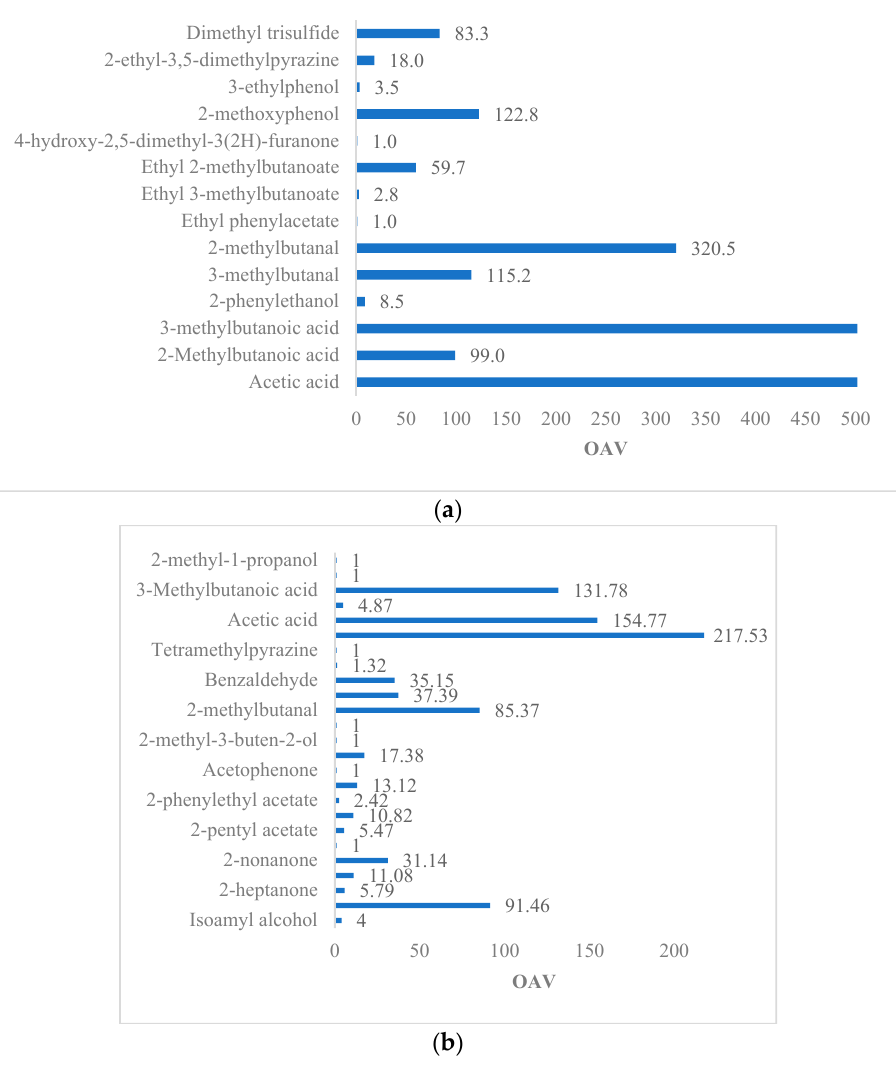
Figure 2. Profile of key volatile compounds present in fermented dry beans determined by ( a ) [42] trinitario cocoa beans and ( b ) [5] trinitario Sacha Gold from Ecuador.